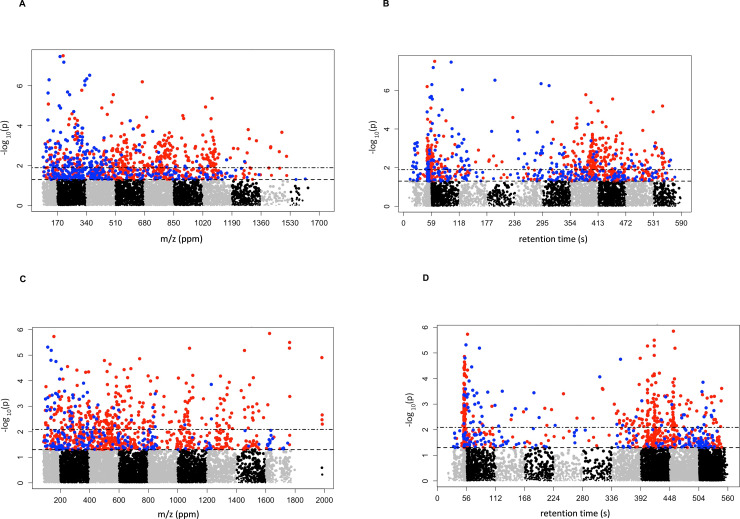
Manhattan plots for metabolome-wide association studies in the first and second cohorts.Each dot represents a unique feature and red dots are features with hazard ratio <1, while blue dots are features with hazard ratio >1. Part A: mass-to-charge (m/z) of features in first cohort plotted against -log10(p-value), Part B: retention time (s) of features in first cohort plotted against -log10(p), Part C: mass-to-charge (m/z) of features in second cohort plotted against -log10(p-value), and Part D: retention time (s) of features in second cohort plotted against -log10(p). Upper horizontal line depicts false discovery rate-adjusted q-value<0.2 and lower horizontal line depicts raw p-value<0.05.